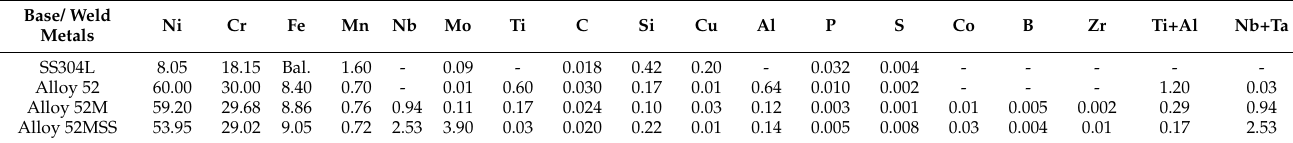
Figure 1. Welding configuration. Table 1. Chemical compositions of base metal and filler metals (wt%).